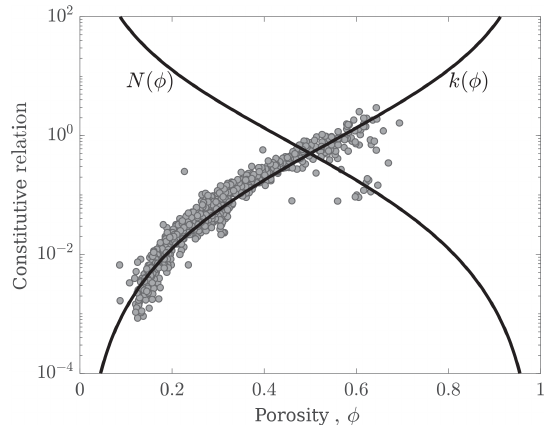
Figure 2. Effective pressure N(φ) and permeability k(φ) constitu- tive relations as functions of the porosity φ for the snow compaction theory. The gray dots are permeability measurements of firn cores from Summit, Greenland (Adolph and Albert, 2014), and show ex- cellent agreement with the Kozeny–Carman permeability model, Eq. (14) with a = 3 and b =